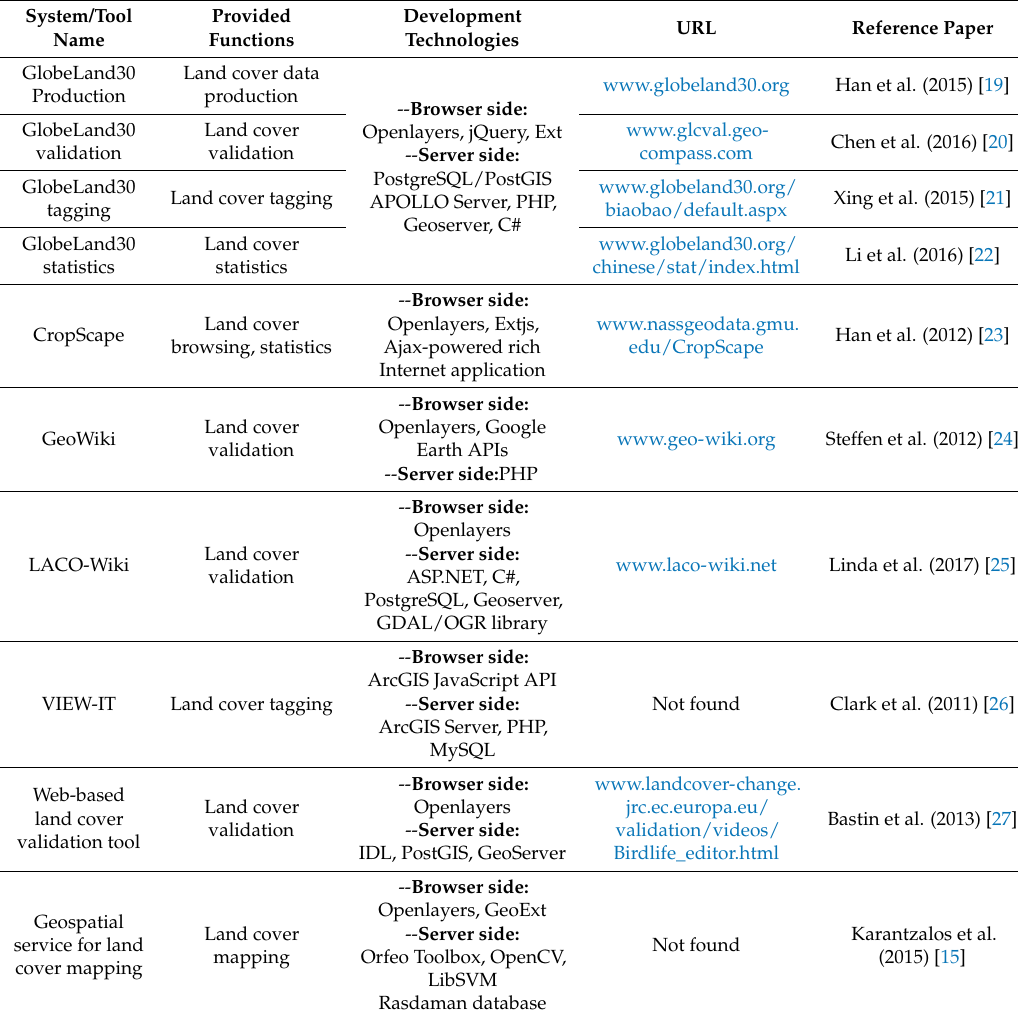
Table 1. A detailed list of existing land cover-related online geoprocessing systems and